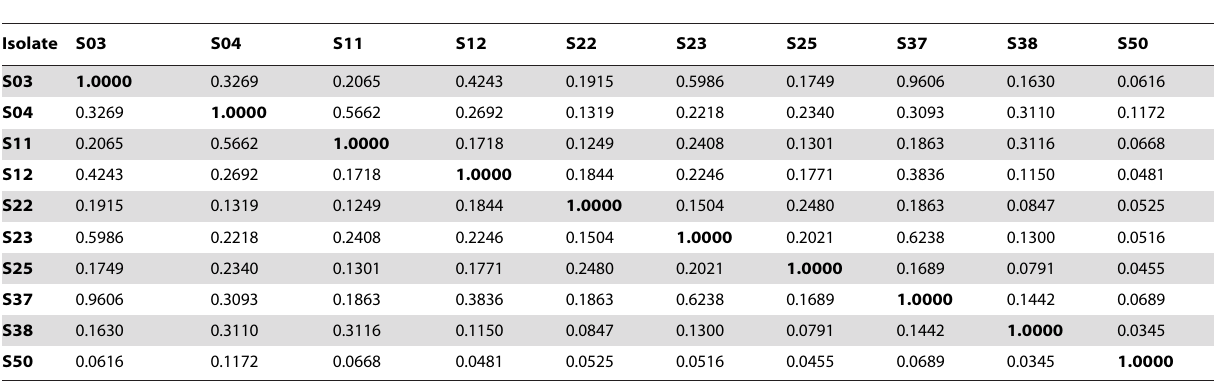
Table 5. In-house CCV analysis of MTB fingerprints of Pseudomonas isolates from the North Sea.